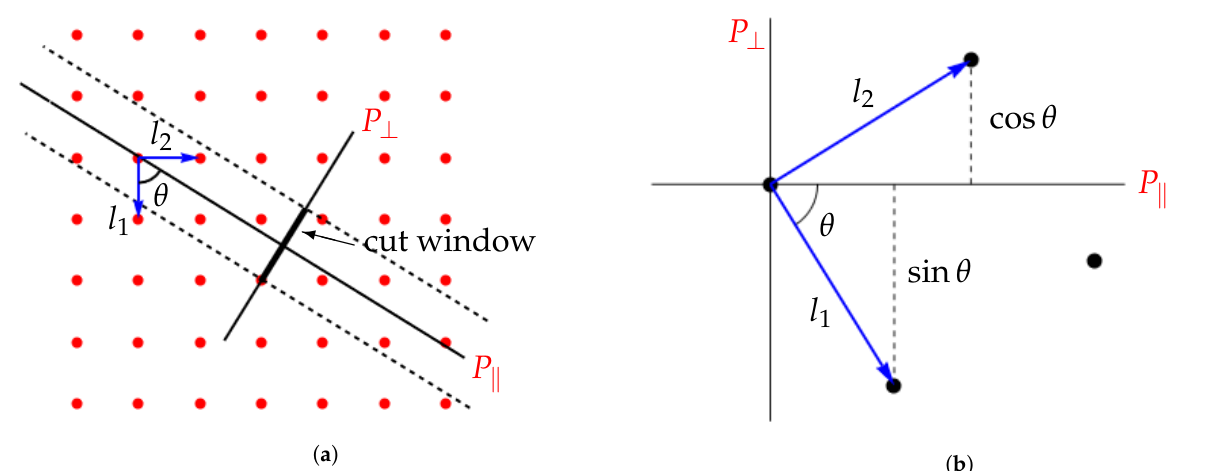
, P , ⊥ (cid:107) is horizontal) (cid:107) and l , 2 1 . . ⊥ ⊥